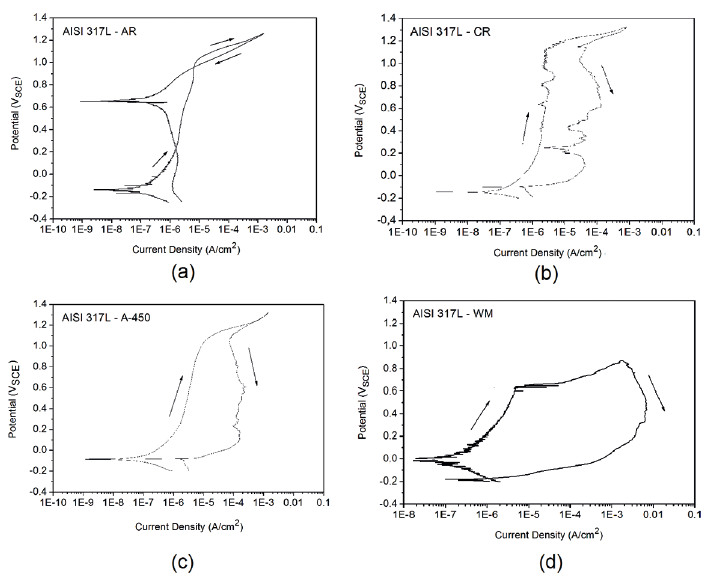
Figure 3. Cyclic polarization curves in 3.5%NaCl (room temperature): (a) AR; (b) 87%- CR; (c) A-450; (d) WM.